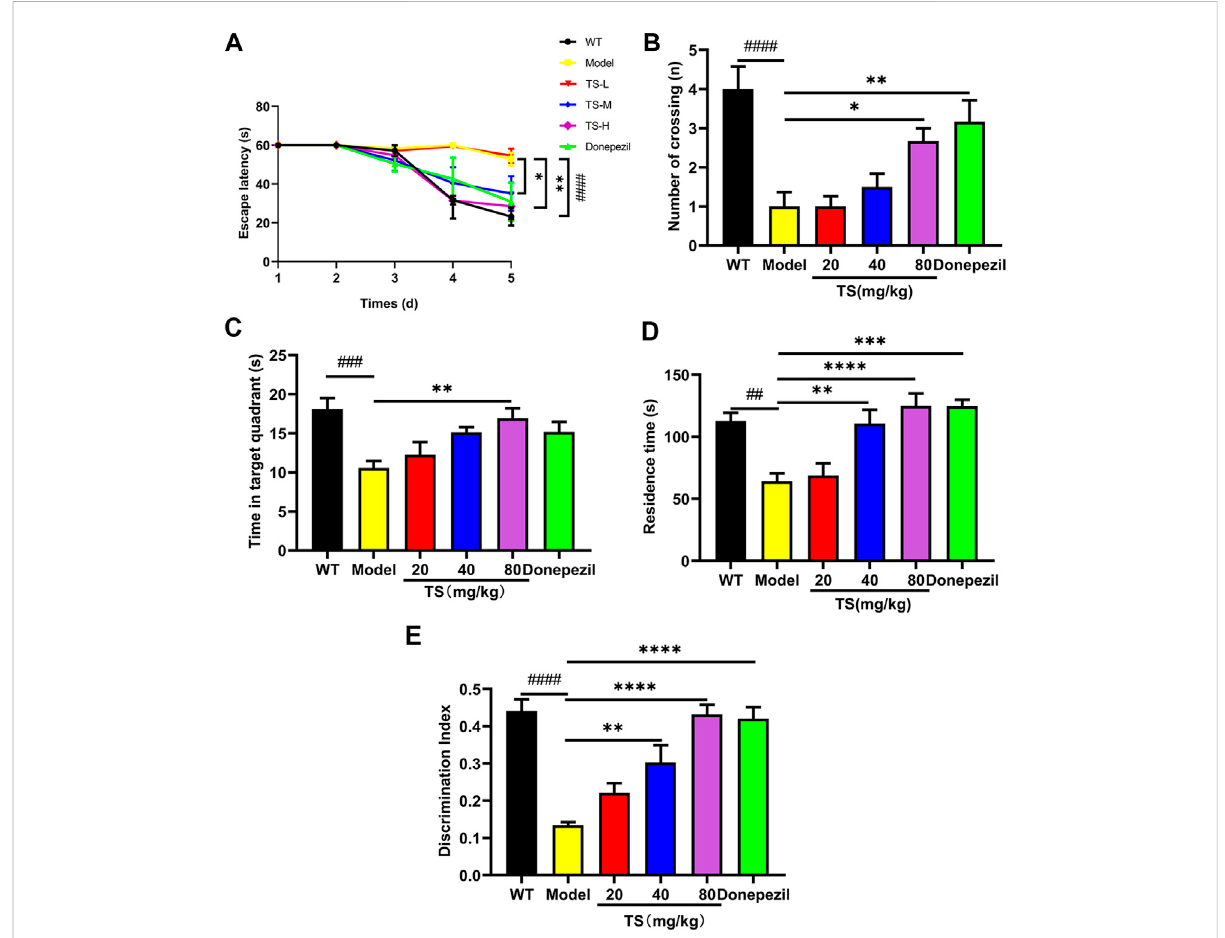
FIGURE 2 TS ameliorated cognitive impairment in APP/PS1 mice. (A) The effect of TS on the escape latency in APP/PS1 mice was investigated by Morris watermaze( #### p < 0.0001,* p= 0.0277,** p =0.0010). (B) TheeffectofTSonthenumberofcrossingplatforminAPP/PS1micewasinvestigatedby Morris water maze ( #### p < 0.0001, * p = 0.0353, ** p = 0.0044). (C) The effect of TS on the time spent in the target quadrant in APP/PS1 mice by Morris water maze ( ### p = 0.0007, ** p = 0.0042). (D) The effect of TS on the residence time in APP/PS1 mice was evaluated by Y-maze test ( ## p =0.0015,** p =0.0024,*** p= 0.001,**** p < 0.0001). (E) TheeffectofTSonthediscriminationindexinAPP/PS1micewasinvestigatedbyNOR test( #### p < 0.0001,** p =0.0021,**** p < 0.0001). # ComparedwithWTgroup;*Comparedwithmodelgroup.Dataarepresentedasmean±S.E.M. ( n =